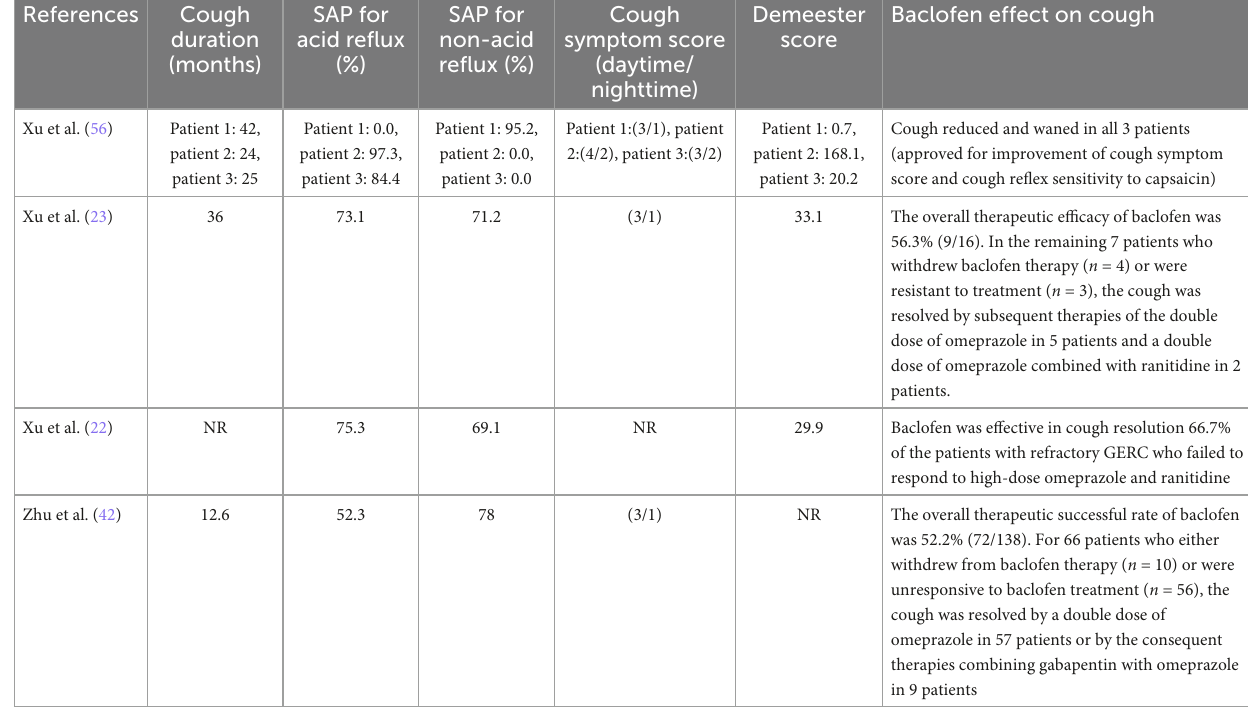
TABLE 7 Outcomes in patients with GERC.